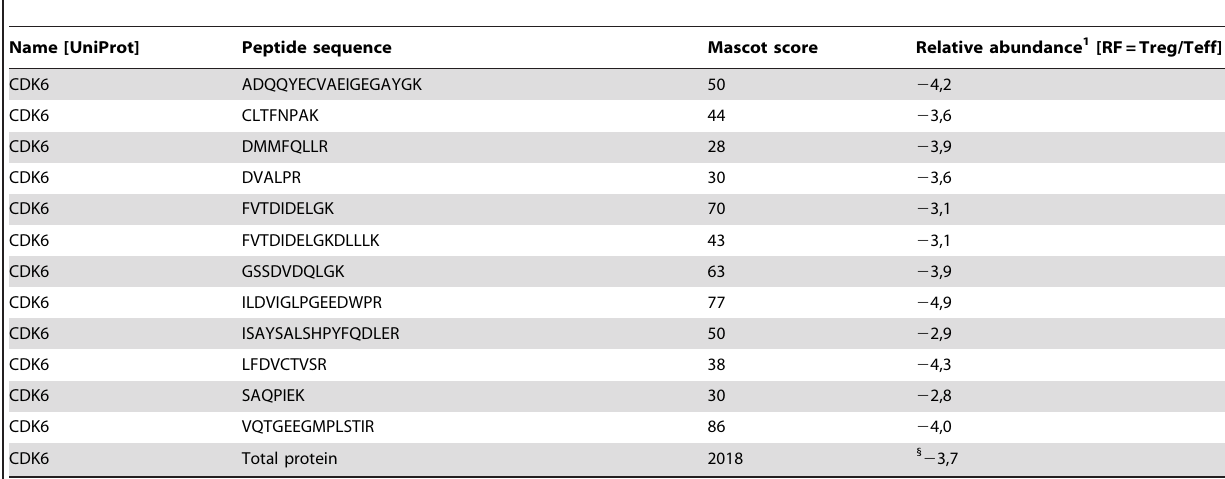
Table 1. Differential CDK6 peptide abundances in Tregs and